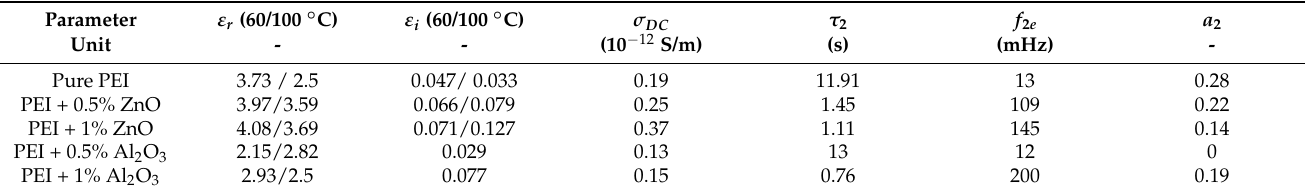
Table 3. Parameters obtained from the fit by the Cole-Cole model for pure PEI and its various types of nanoparticles at 100 ◦ C ( ε r and ε i at frequency 50 Hz, σ DC is the DC conductivity (10 − 12 S/m), τ is the relaxation time of α -relaxation, a is the shape